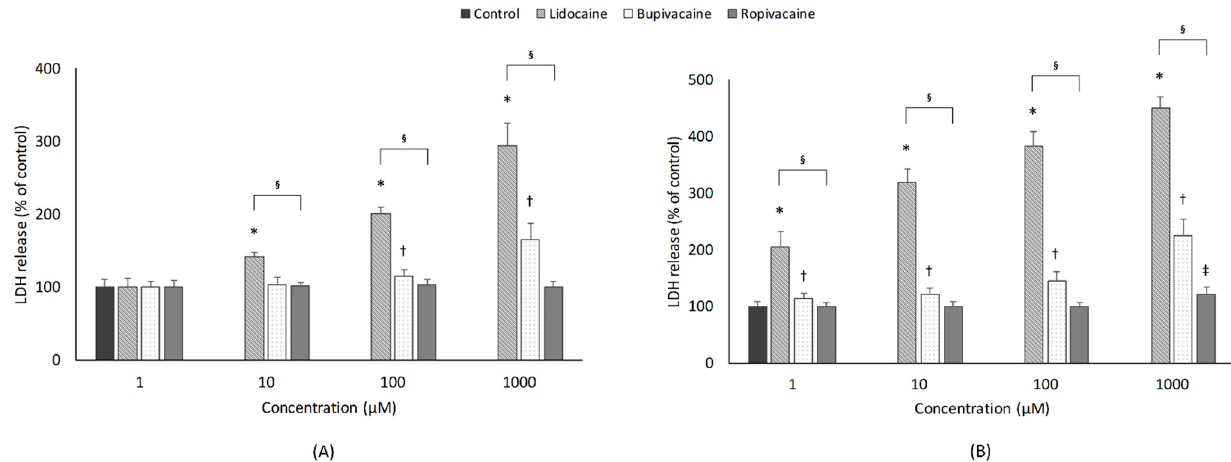
Figure 2. Effects of local anesthetics on cytotoxicity, which was assessed with lactate dehydrogenase (LDH) leakage. Developing motor neurons were exposed to the indicated concentrations (1, 10, 100, or 1000 µM) of local anesthetics for ( A ) 1 h or ( B ) 24 h. All data are expressed as means ± standard deviations. Differences between the results were evaluated by two-way ANOVA, followed by Dunnett’s test for multiple comparisons. * p < 0.05, lidocaine vs. control group. † p < 0.05, bupivacaine vs. control group. ‡ p < 0.05, ropivacaine vs. control group. § p < 0.05, differences among the 3 groups by ANOVA.